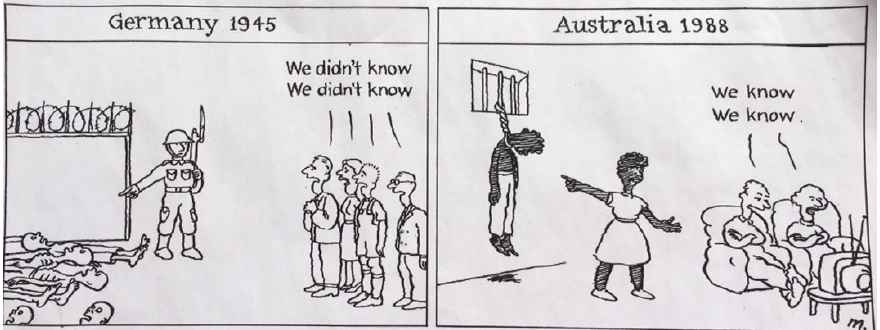
Figure 2. Matthew Martin, from Australian Cartoon Museum’s 2014 exhibition, ‘She’ll be right, mate? An Indigenous History in Australian Cartoons’, (originally published Sydney Morning Herald, 1988). Courtesy Matthew Martin.